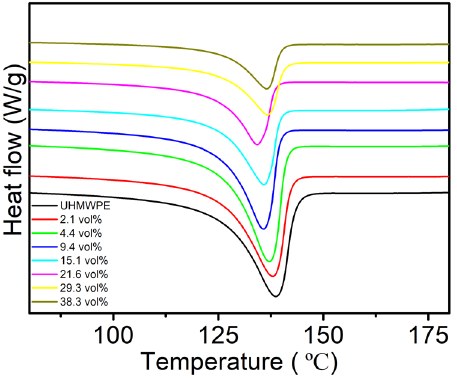
Figure 6: The DSC curves for the UHMWPE and BN@UHMWPE composites with di ff erent loadings of